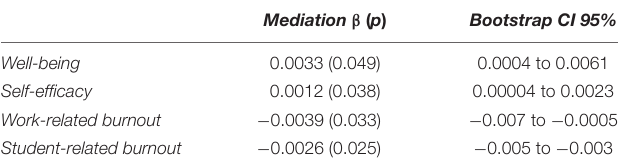
TABLE 4 | Statistical output for the mediation tests investigating praxis shock as a mediator of the relationship between years teaching and significant